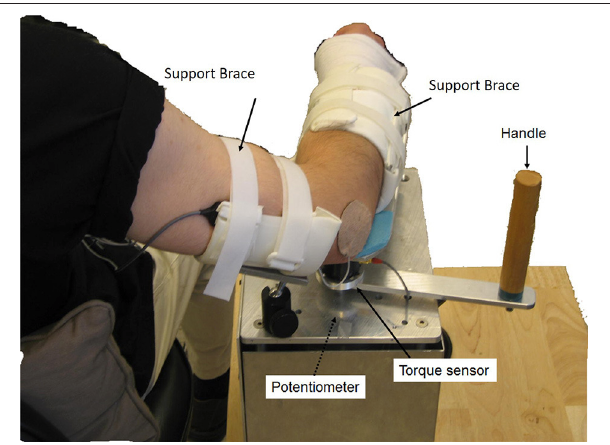
FIGURE 1 | Experimental setup. The participant sat next to the MSE with 75 ◦ shoulder abduction. The participant’s upper arm and forearm were then strapped onto the supporting braces with the elbow flexion axis aligned with the MSE rotation axis. A torque sensor and a hollow-shaft potentiometer were used to measure the joint torque and joint position, respectively. Surface EMG electrodes were used to record EMG signals of biceps brachii and triceps